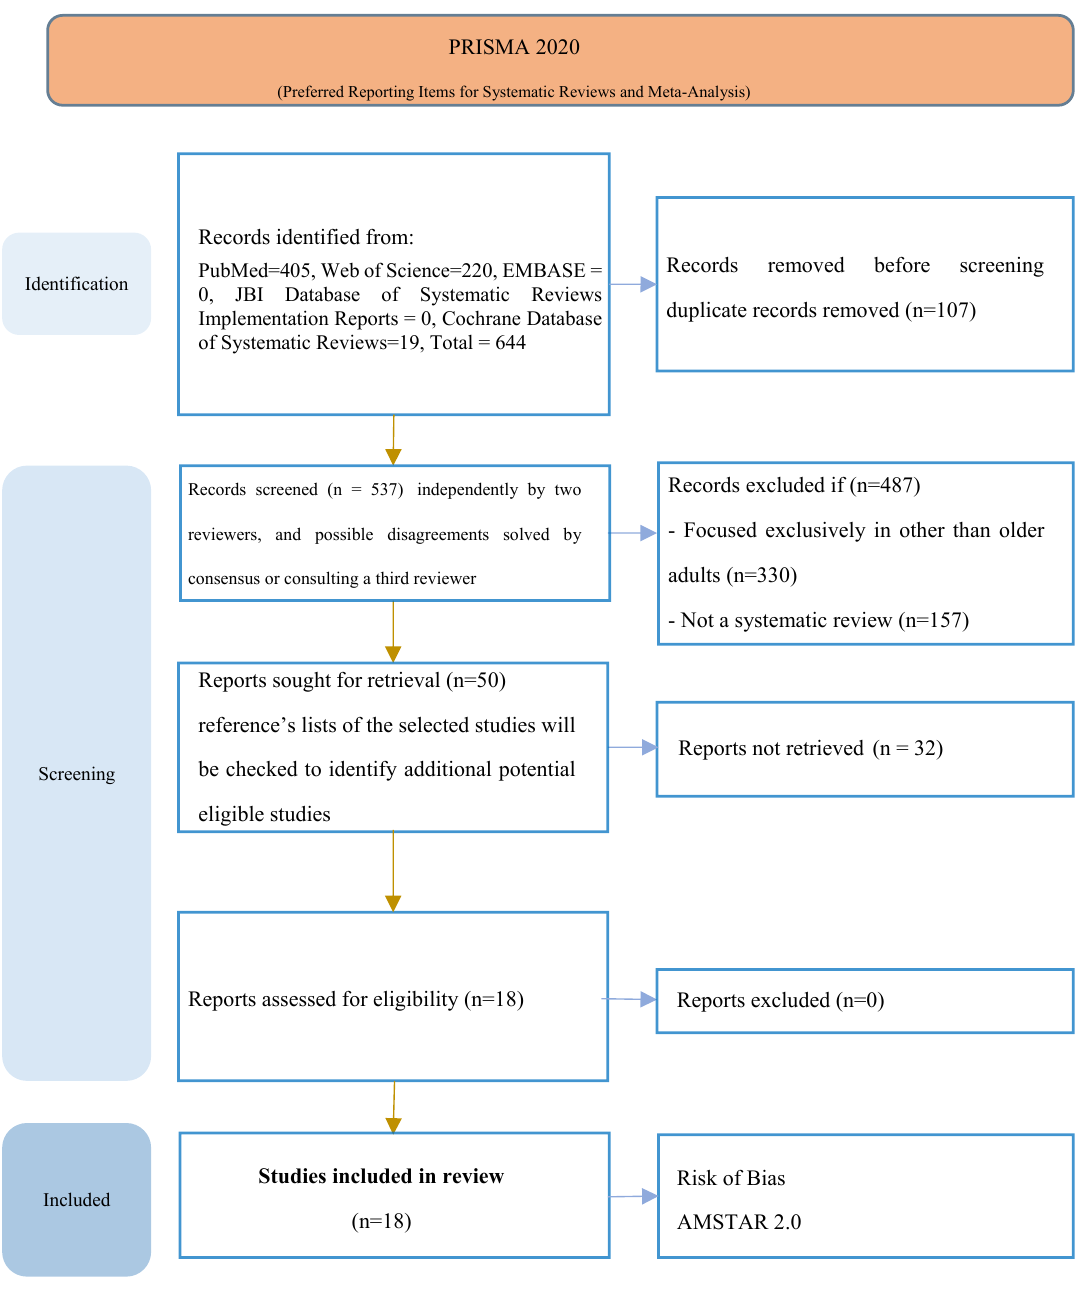
Figure 1. PRISMA Flowchart.